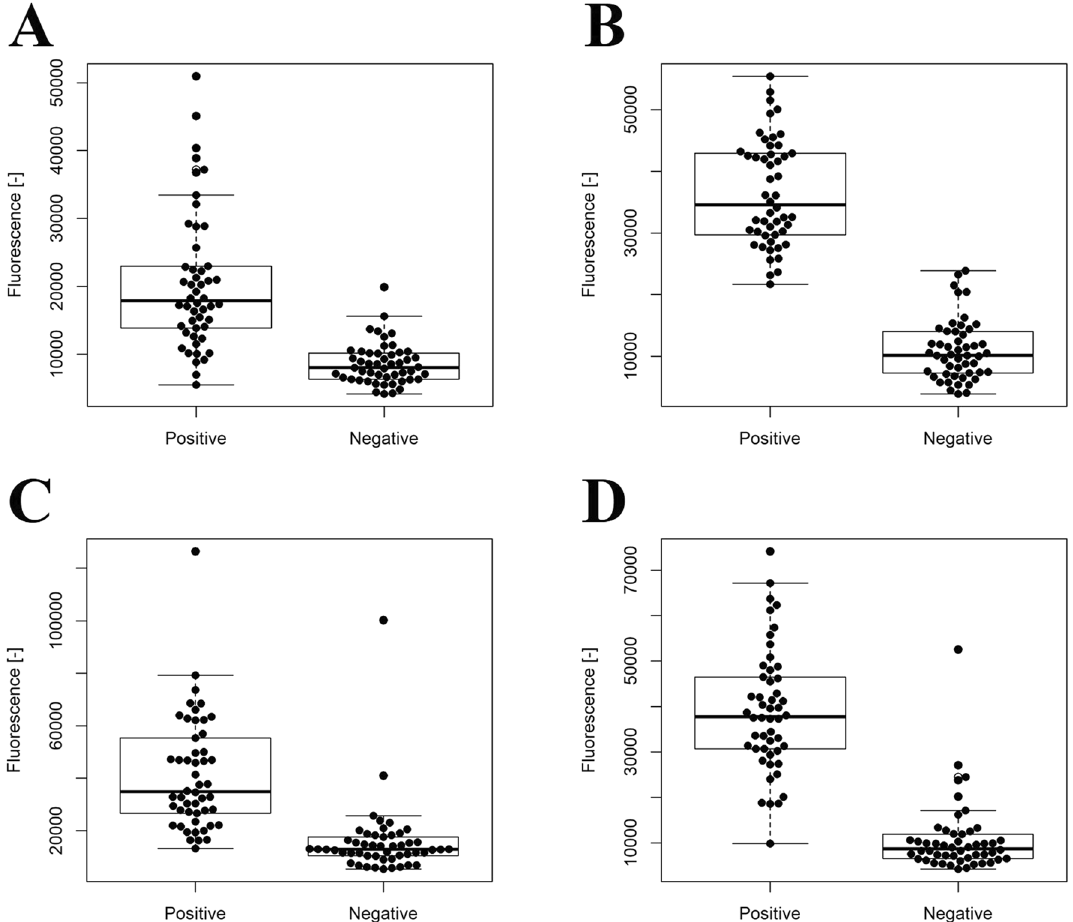
Figure 4. Bile acid binding activity of the top and bottom 50 peptides. In order to evaluate the 4-mer ( A ), 5-mer ( B ), 6-mer ( C ), and 7-mer ( D ) models, the 50 peptides predicted to have the most and least bile acid binding activity were synthesized, and their bile acid-binding activity was evaluated using a peptide array. In each group, 50 peptides were selected. The 50 peptides with the most predicted activity designated as ‘positive’, and the 50 peptides with the least predicted activity designated as